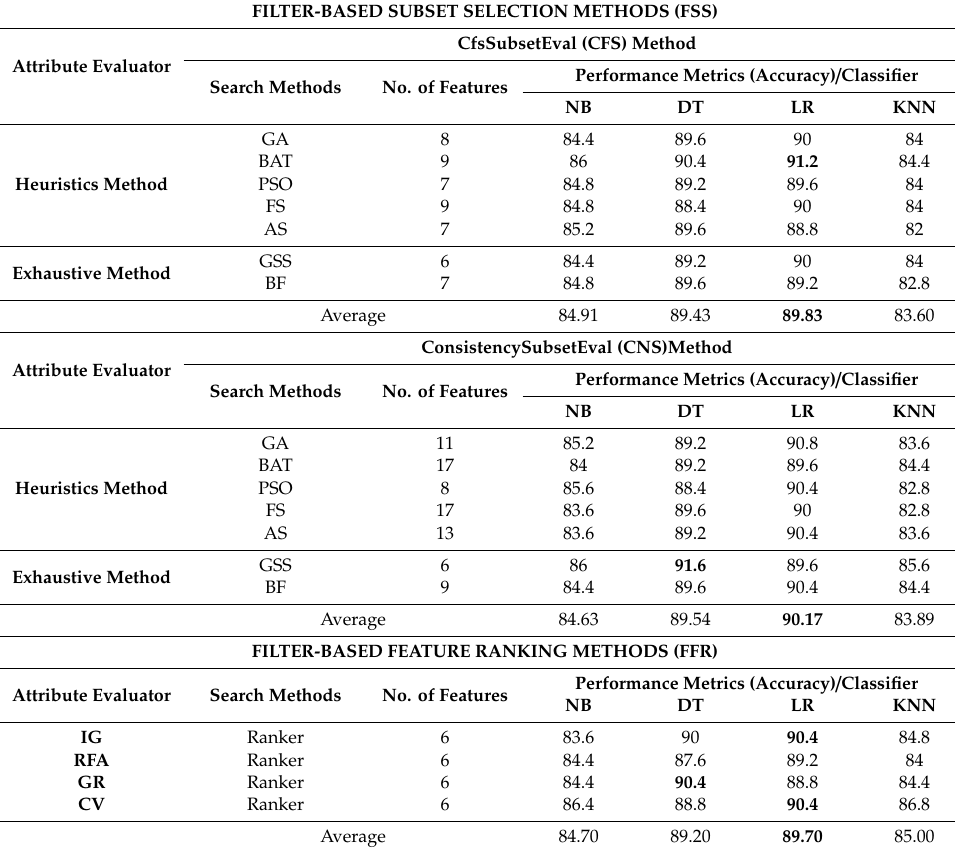
Table 13. Performance Accuracy Values of FS-based Prediction Models on MW1